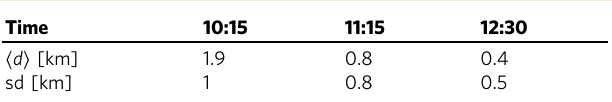
Table 3 2018 fi eld